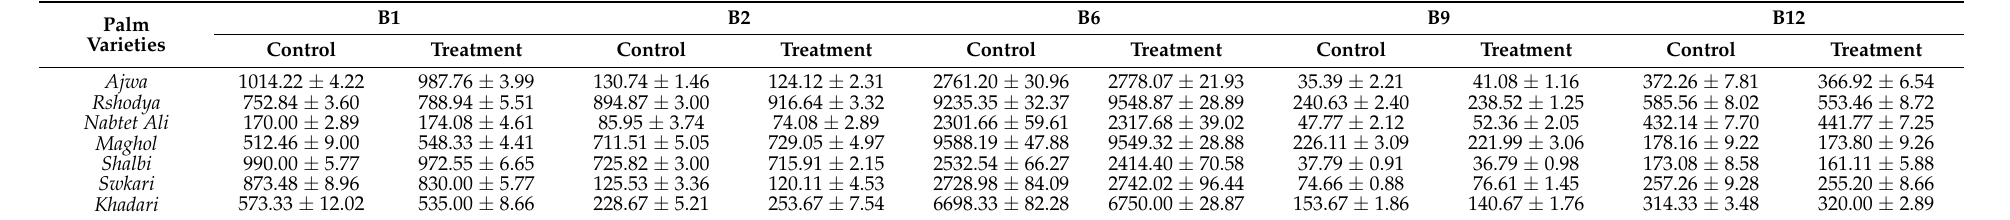
Table 2. The influence of SDBD plasma on water-soluble vitamins of different varieties of palm dates.